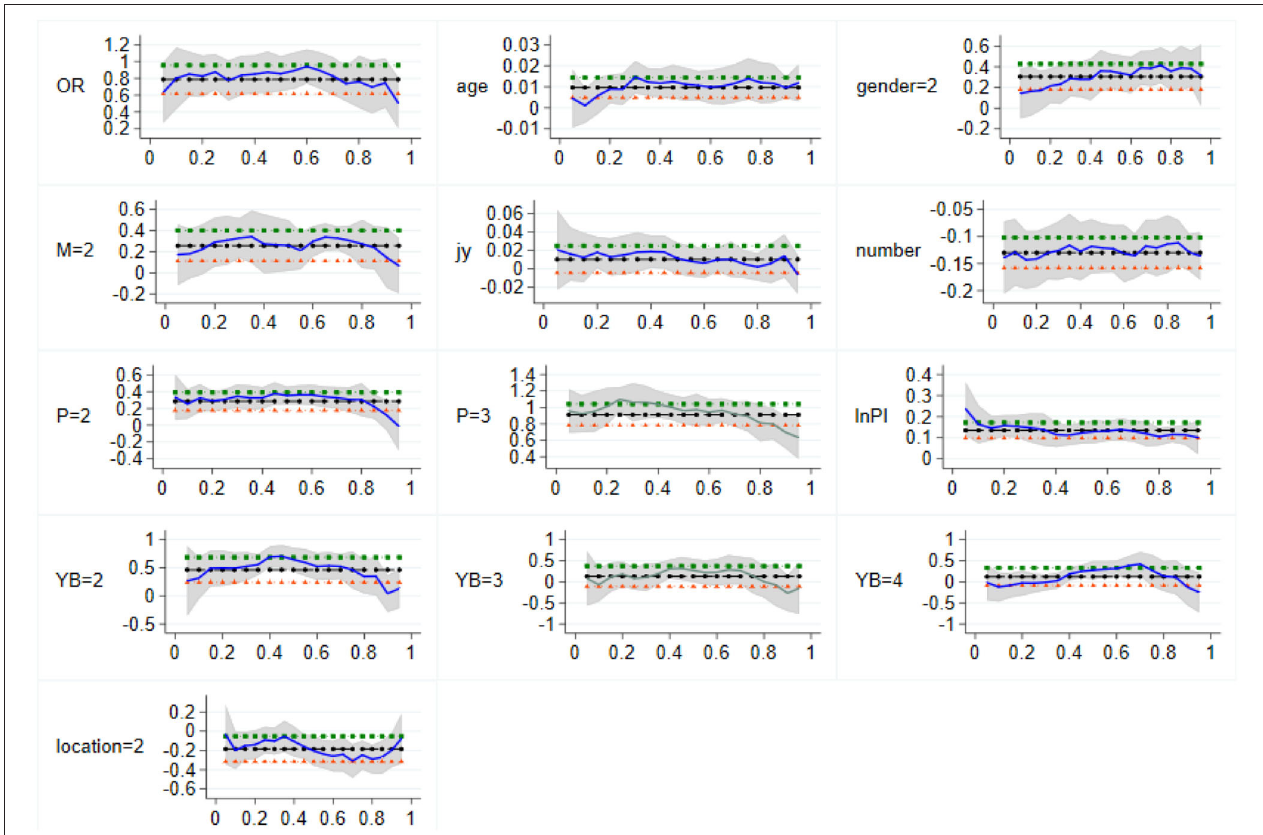
FIGURE 3 | Variation of sample quantile regression coefficients in Central China. The vertical coordinate is the estimated value, whereas the horizontal coordinate is the different